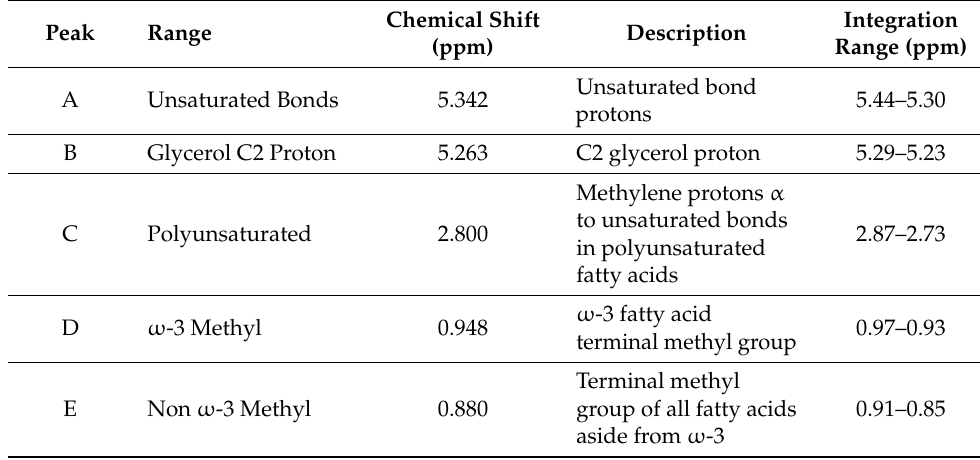
Table 1. Integrated regions used in this